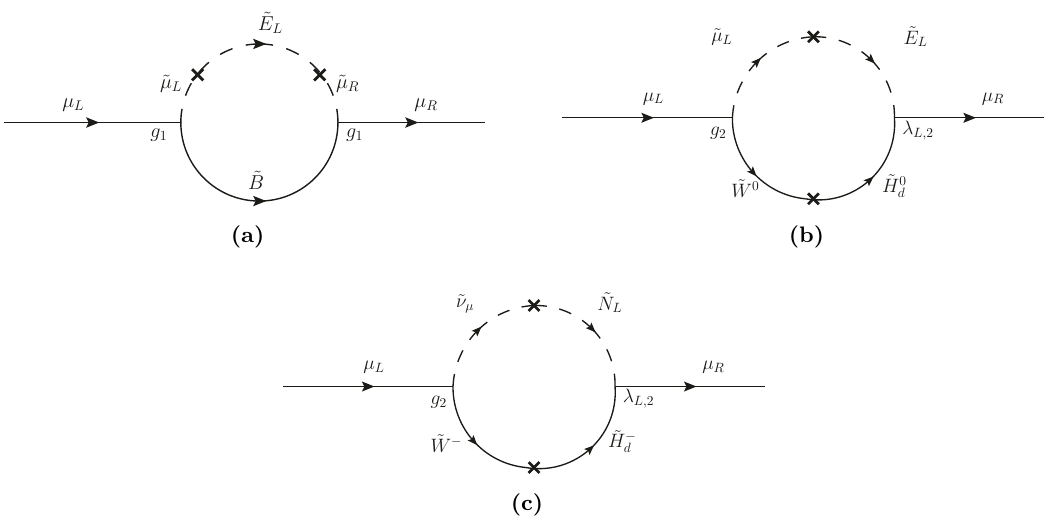
2) in the LD model. The photon line attached to (cid:22) (cid:0)